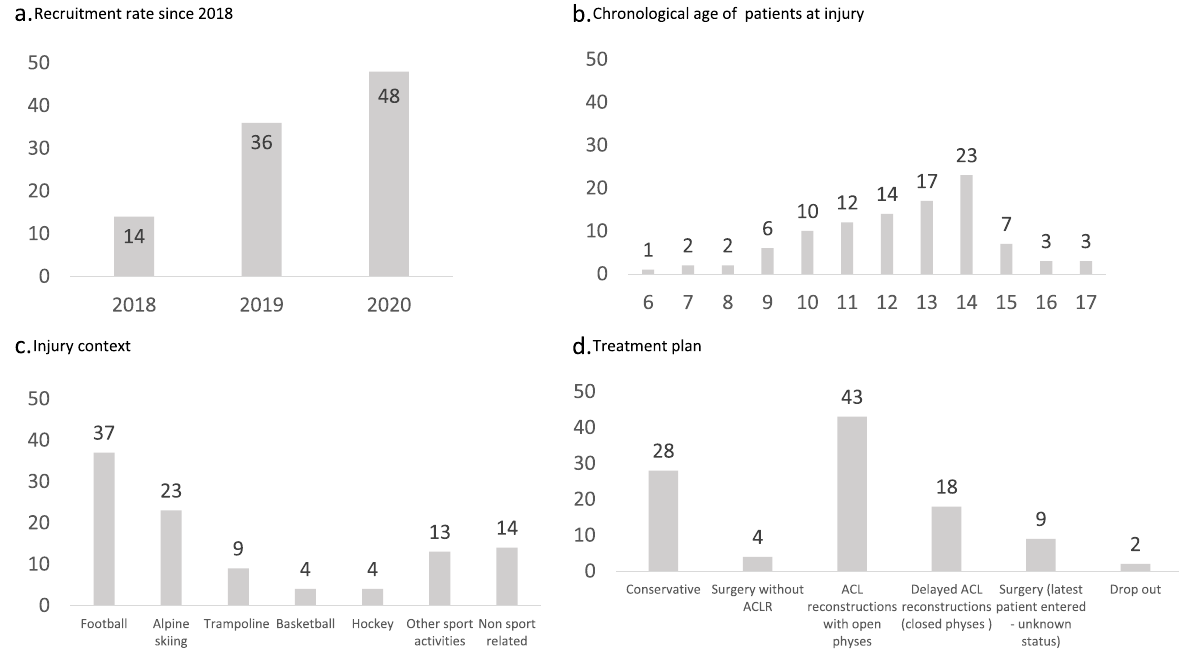
Fig. 1 Preliminary epidemiological data from PAMI. a Number of patients recruited in the PAMI since 2018 (2 patients recruited in 2021). b Chronological age of patient at injury ( n